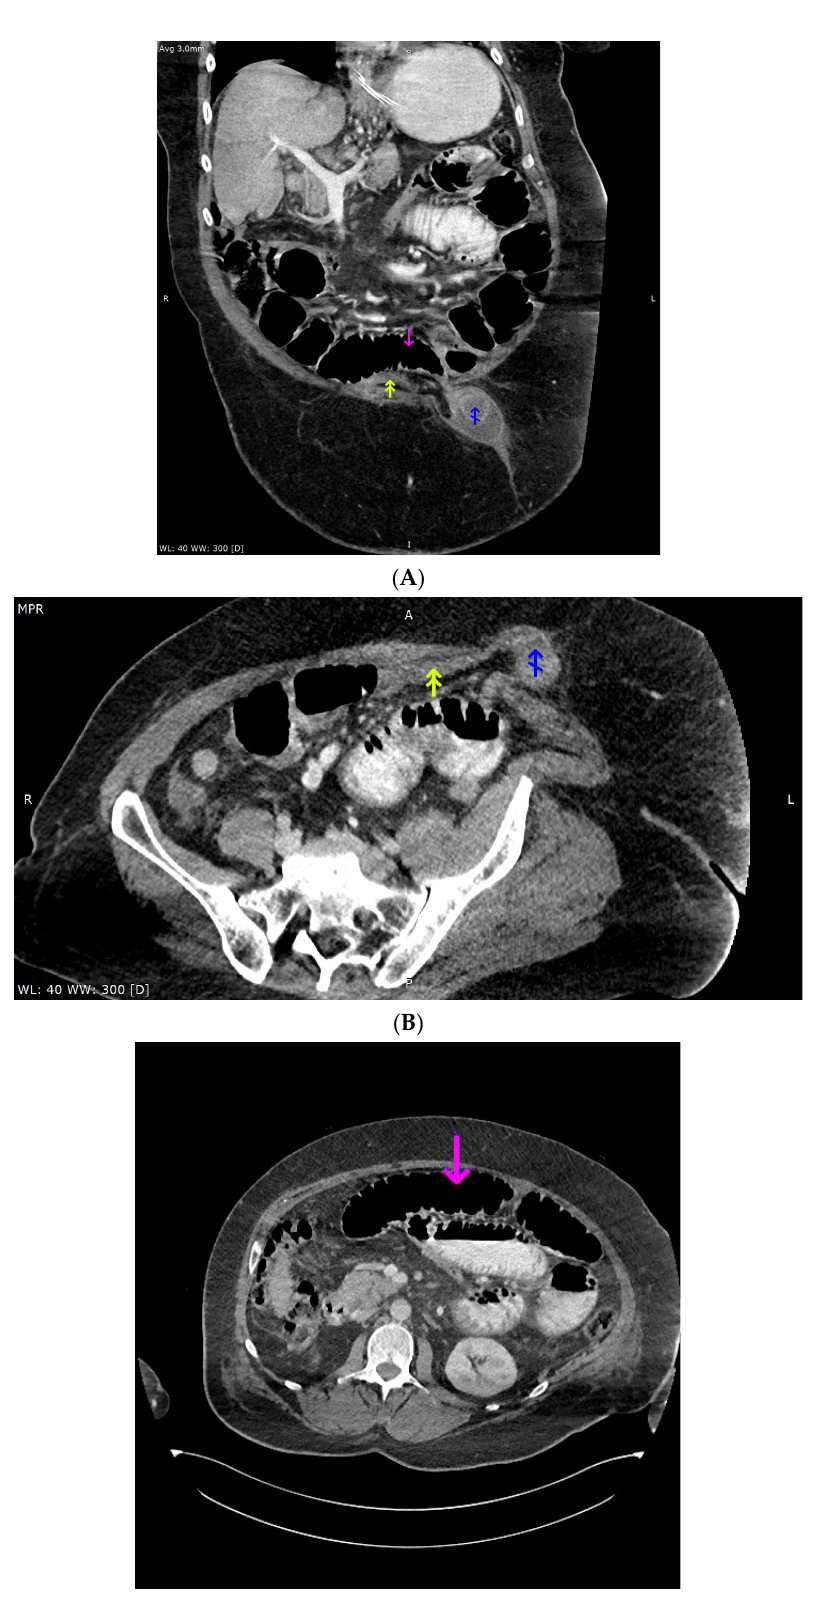
Figure 2. ( A ) Computed tomography imaging of the abdomen and pelvis, portal-venous phase, oral contrast administered, oblique (closest to coronal) reconstruction (3 mm). Magenta arrow points to